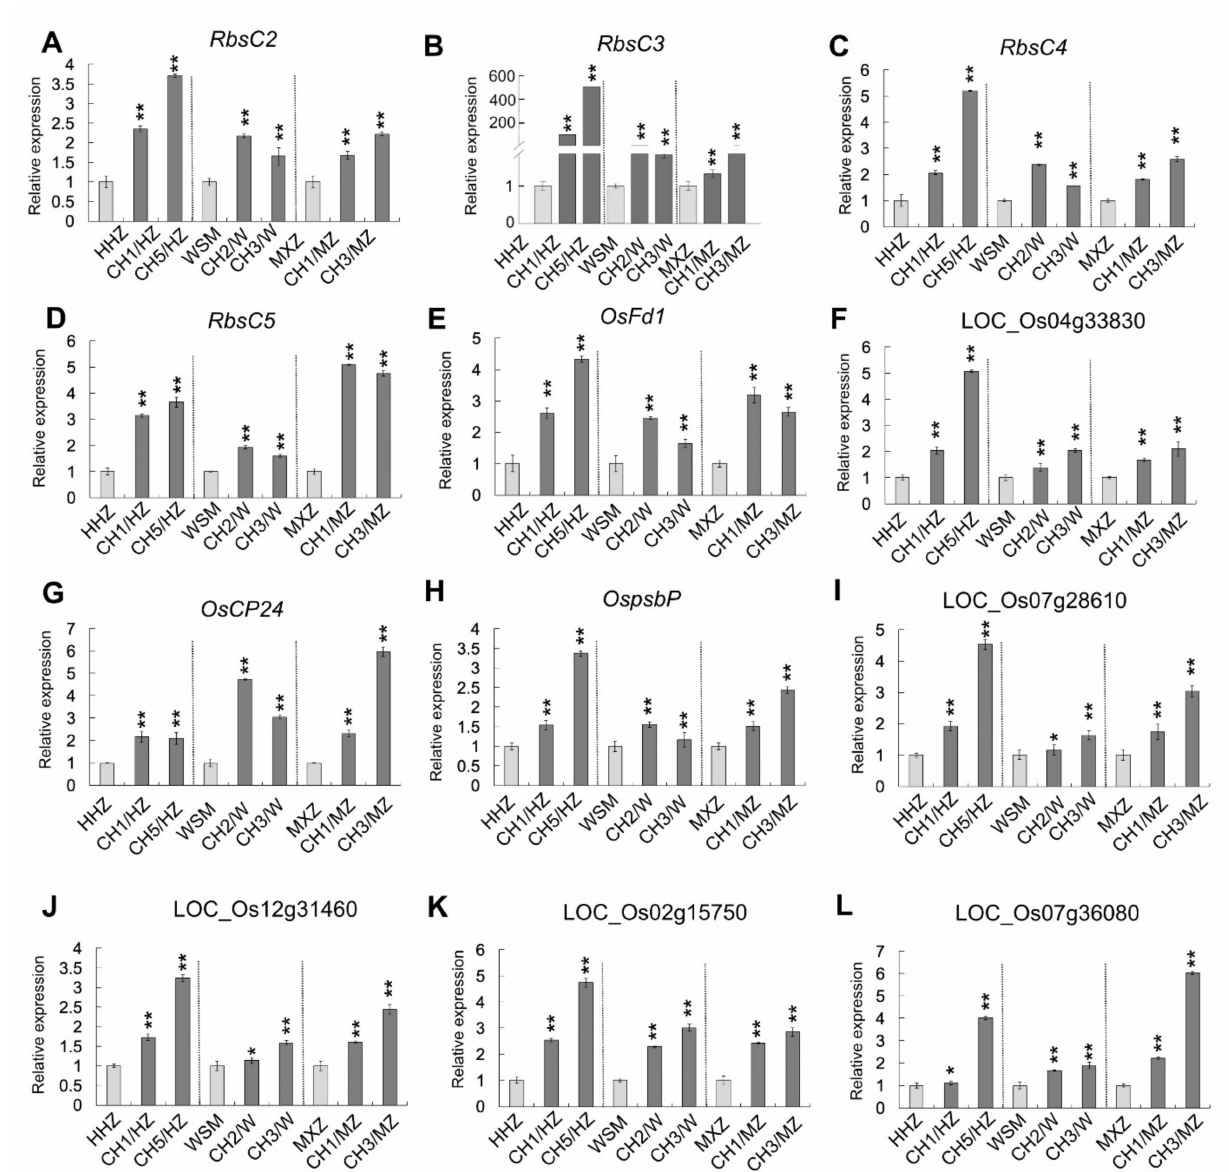
Figure 7. Expression analysis of photosynthesis-related genes in three varieties. ( A – L ) qRT-PCR analysis of the expression levels of photosynthesis-related genes in HHZ, MXZ, WSM, and OsHXK1-Cas9 plants according to the RNA-seq data. OsActin1 , UQ5, GAPDH were used as the internal reference genes. The data shown are the means ± SDs; *, 0.01 ≤ p < 0.05; **, 0.001 ≤ p < 0.01, according to Student’s t